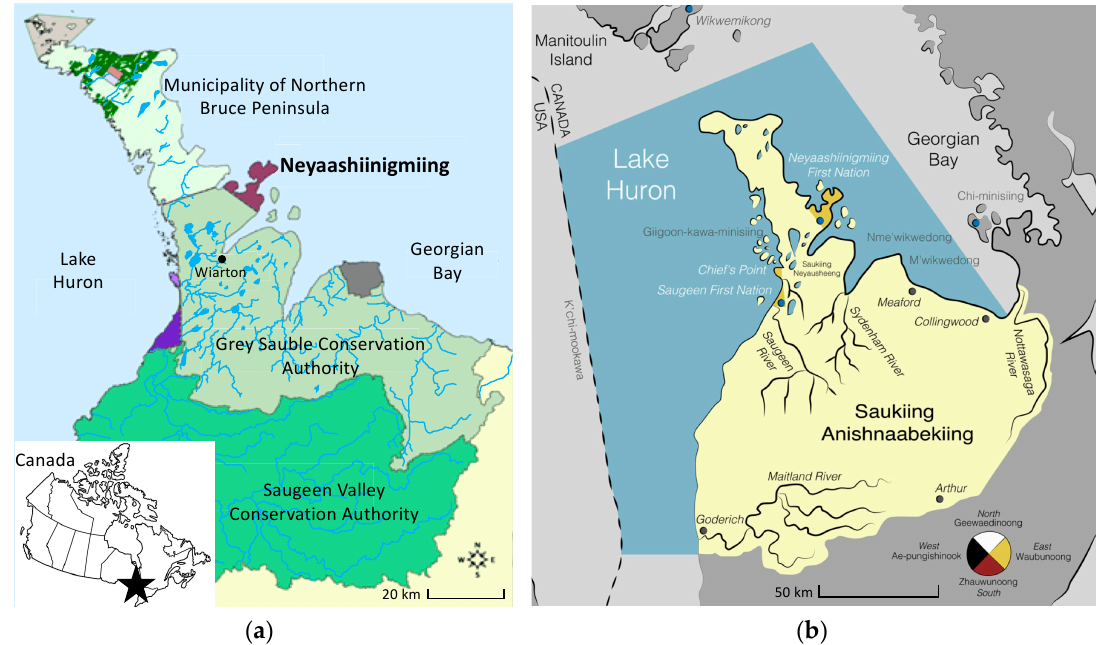
Figure 1. ( a ) Location of Neyaashiinigmiing in relation to local conservation authorities and to Canada (adapted from [50,51]); ( b ) the traditional territory of the Saugeen Ojibway Nation (adapted from [49]).